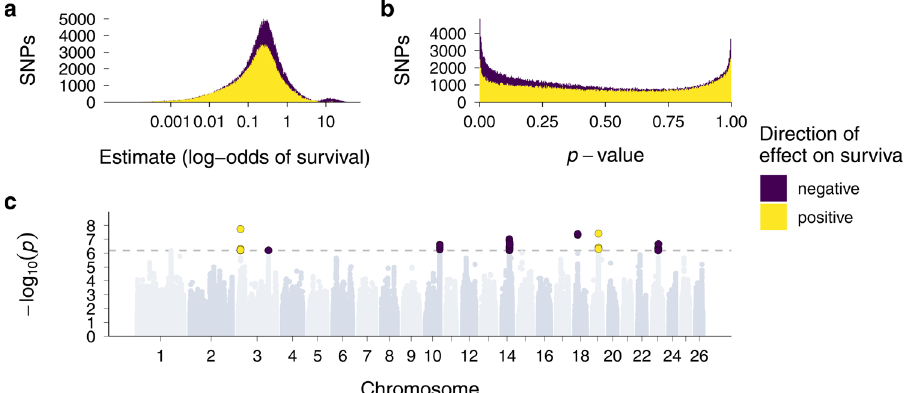
Fig. 4 GWAS of SNP-wise ROH status effects on annual survival. Regional inbreeding depression was conceptualised and tested using two binary ROH status predictors. One of the predictors quanti fi ed the ROH status of allele A (in ROH = 1, not in ROH = 0), while the other quanti fi ed the ROH status of allele B. a Distribution of effect sizes for SNP-wise ROH status effects. b Distribution of p -values for SNP-wise ROH status effects. The yellow histograms showing positive effects are superimposed on top of the purple histograms showing negative effects to highlight a substantially larger proportion of negative ROH status effects than expected by chance. c Manhattan plot of the ROH status p -values across the genome. The dotted line marks the genome- wide signi fi cance threshold for a Bonferroni correction which was based on the effective number of tests when accounting for linkage